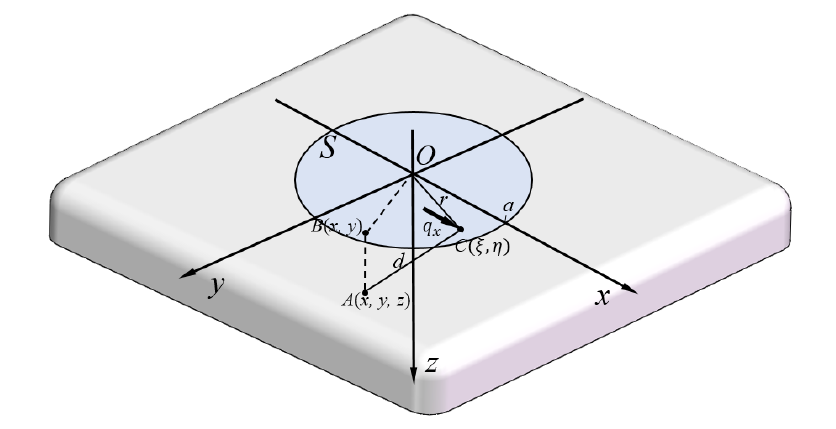
Figure 7. Tangential traction q acting over the loaded area S